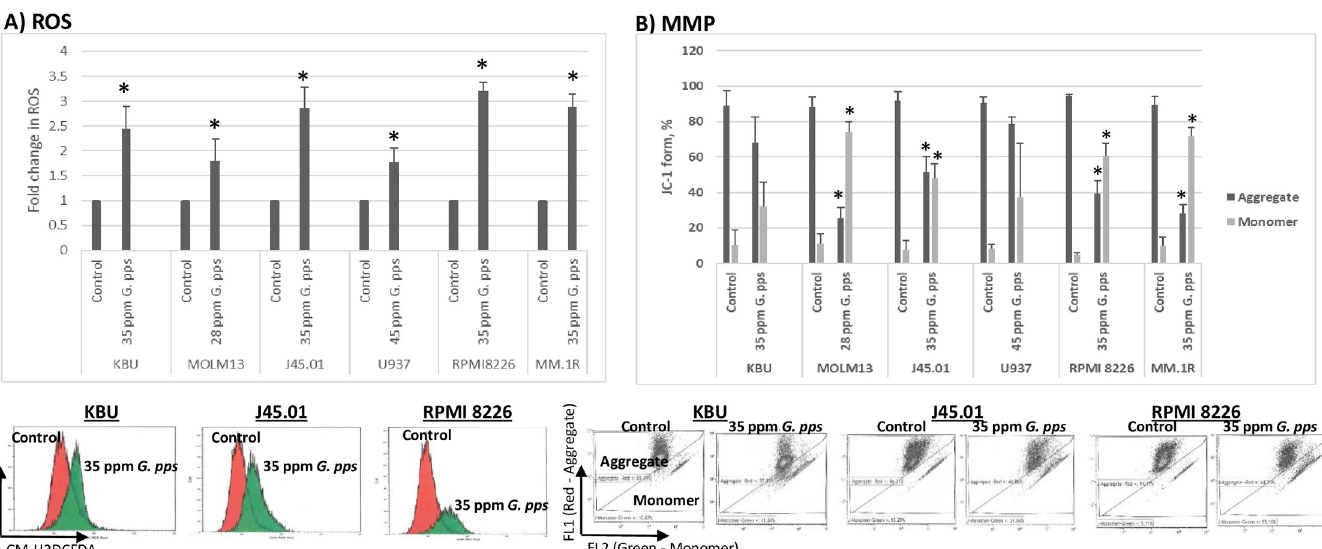
PLOS ONE | https://doi.org/10.1371/journal.pone.0252541 May 28,